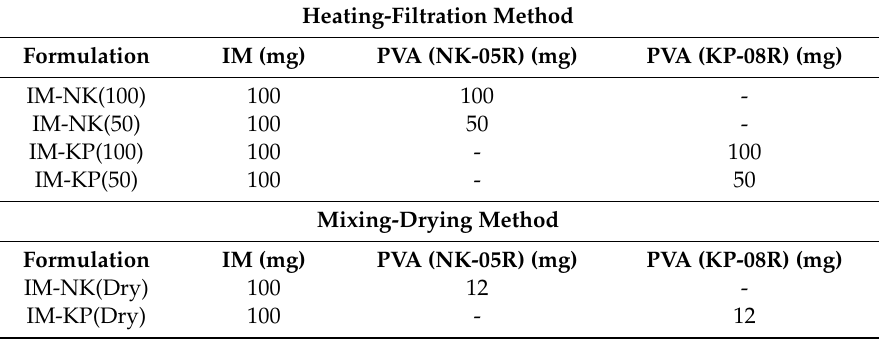
Table 2. Composition of the Mucoadhesive Microparticles of the Indomethacin (IM) Prepared by the Heating-Filtration Method and Mixing-Drying